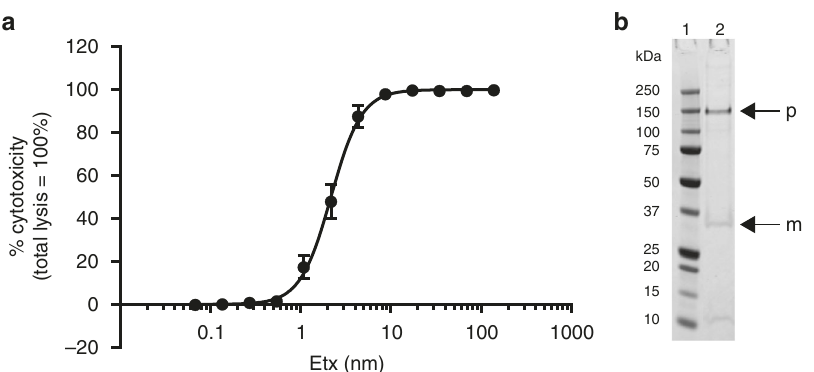
Fig. 1 Cytotoxic activity of wild-type epsilon toxin (Etx) towards Super Dome cells. a The cytotoxic activity of trypsin-activated recombinant wild-type Etx towards Super Dome cells was determined by measuring the release of lactate dehydrogenase (LDH) from lysed cells. Results were normalized to the signal from cells treated with Dulbecco ’ s phosphate-buffered saline (DPBS) only (0% lysis) and cells treated with 0.9% (v/v) Triton X-100 (100% lysis). Results are presented as the mean of triplicate assays, each performed in triplicate (±SEM). b Puri fi ed Etx pore was separated by sodium dodecyl sulfate- polyacrylamide gel electrophoresis (SDS-PAGE) and visualized by Coomassie staining. Arrows indicate the positions of Etx pore (p) and Etx monomer (m). Source data are provided as a Source Data fi le